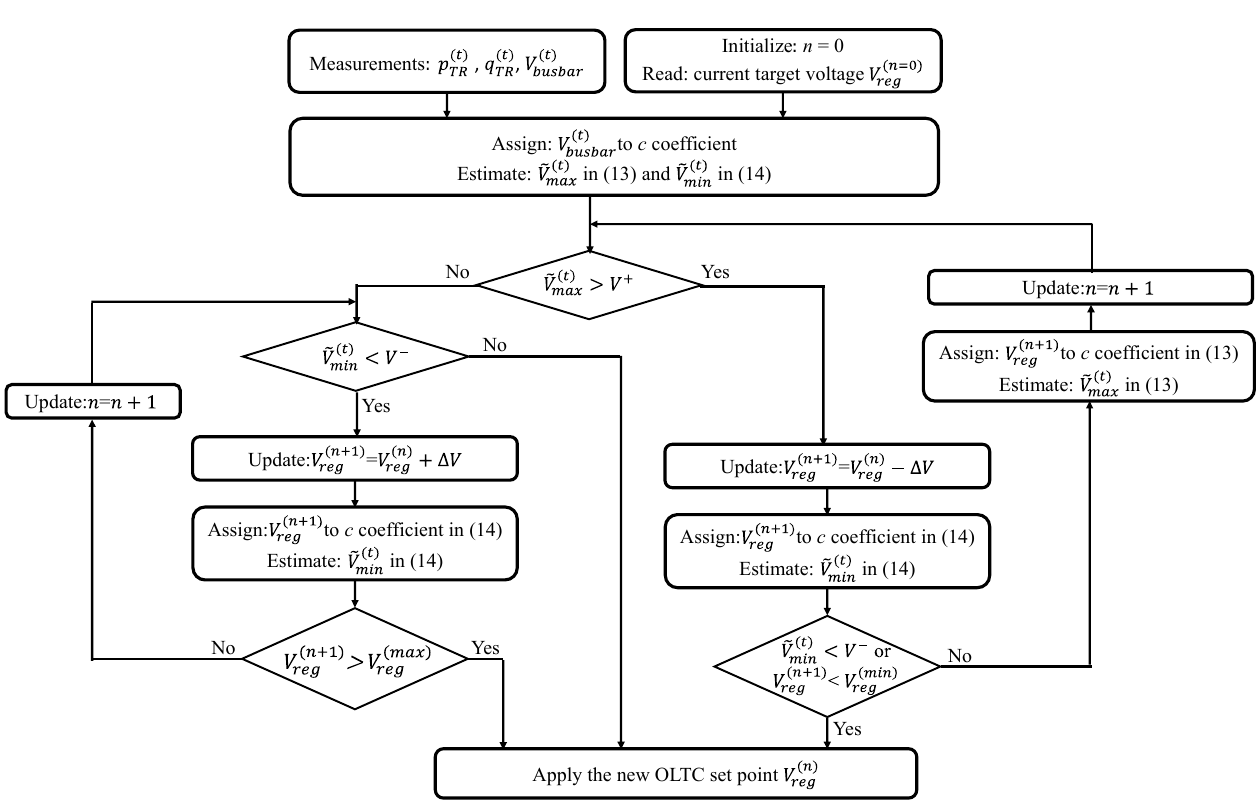
Figure 2. Flow chart of the operational stage.